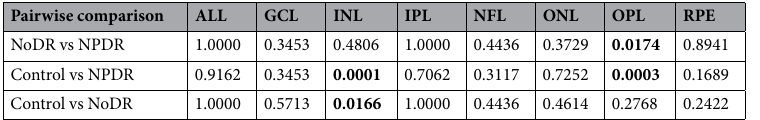
Table 4. The p-values from the permutation-based hypothesis tests to test differences between the average PDFs of the subjects in each pairwise comparison. Statistically significant differences are shown in bold